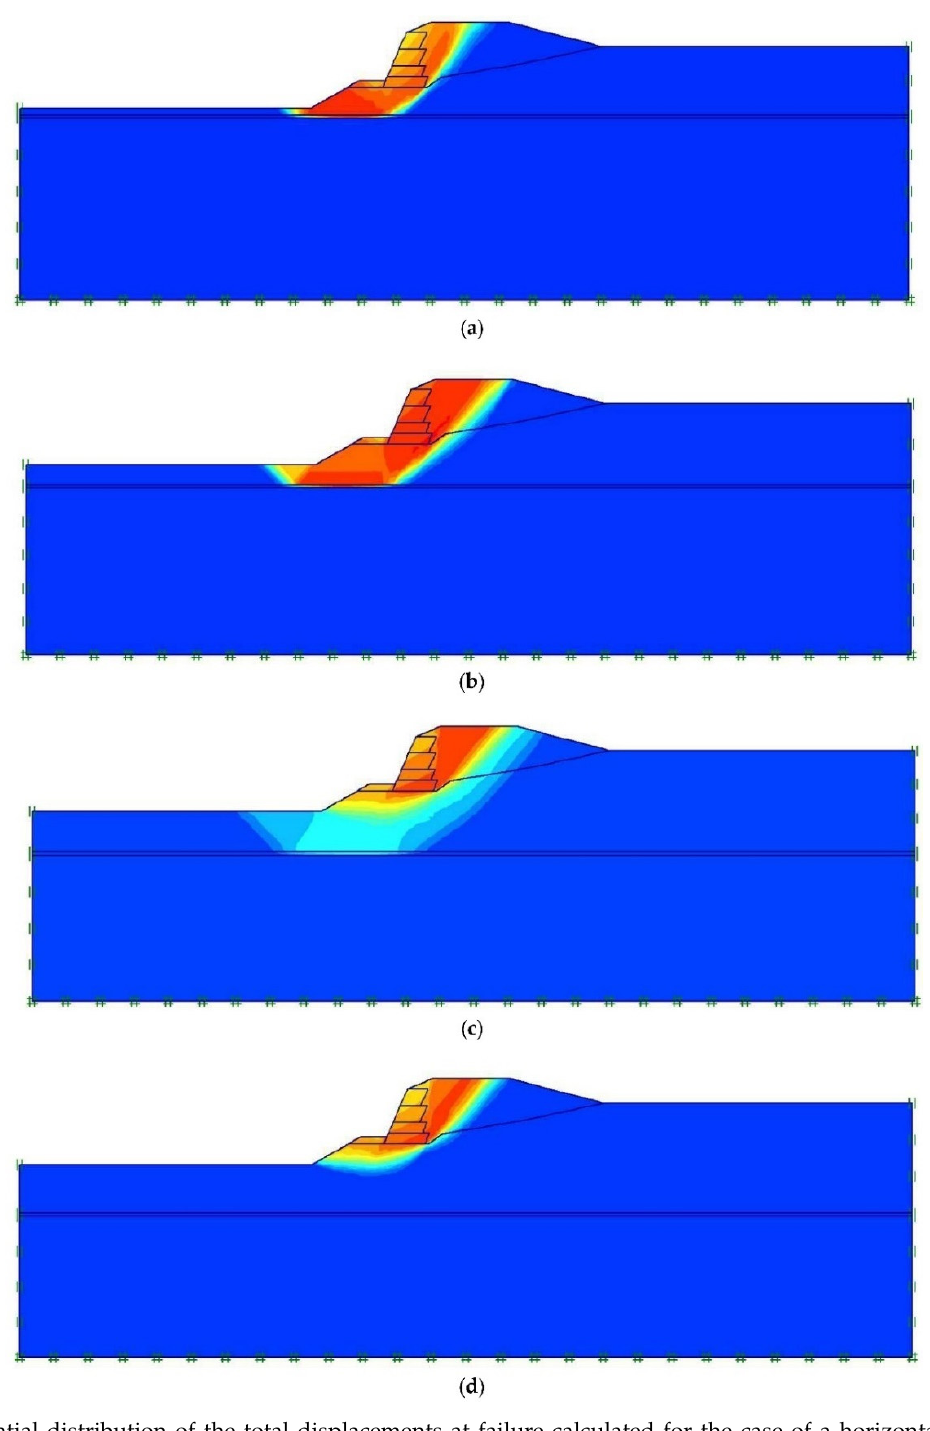
Figure 5. Spatial distribution of the total displacements at failure calculated for the case of a horizontal weak layer with c ′ 2 = 0.2 kPa and φ′ 2 = 10° located at depth equal to ( a ) z i = 4 m (z i /H = 0.47), ( b ) z i = 6 m (z i /H = 0.71), ( c ) z i = 9 m (z i /H = 1.06) and ( d ) z i = 10 m (z i /H = 1.18).